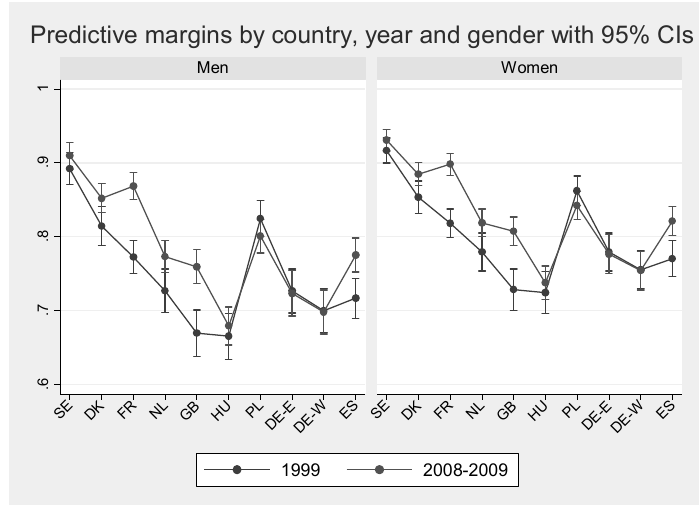
Figure 2 : Margins plot of the predicted probabilities of supporting the nurturing father over the years by gender. Controlled for age, education, employment status, children and marital status (no weights